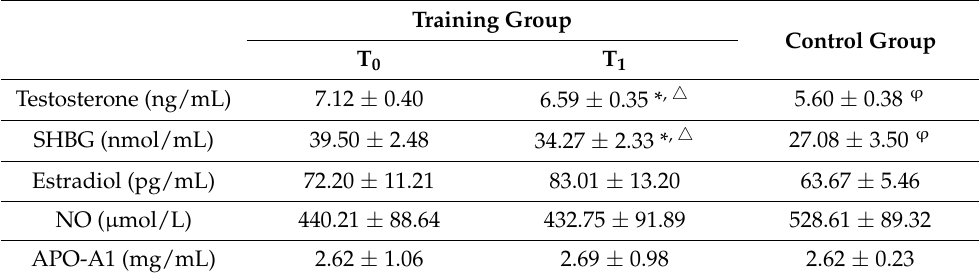
Table 2. Mean values of testosterone, SHBG, Estradiol, NO and APO-A1 serum concentrations in training groups before and after the training season and in the control group.